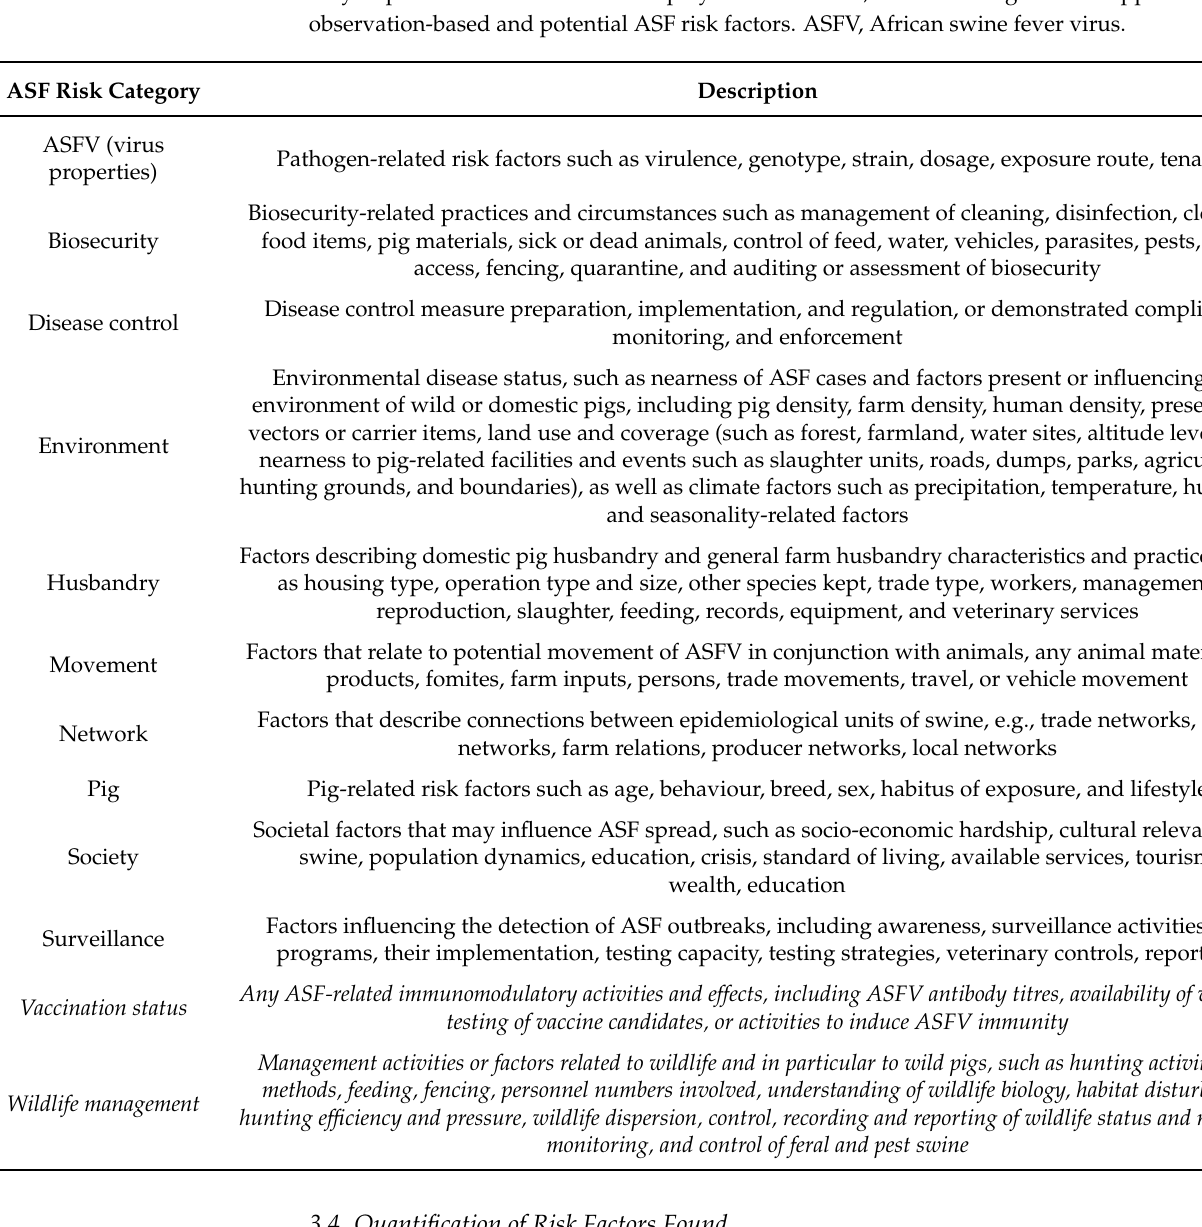
Table 2. Description of risk factor categories for African swine fever. Risk categories applicable only to potential risk factors are displayed in italic font; all other categories are applicable to both observation-based and potential ASF risk factors. ASFV, African swine fever